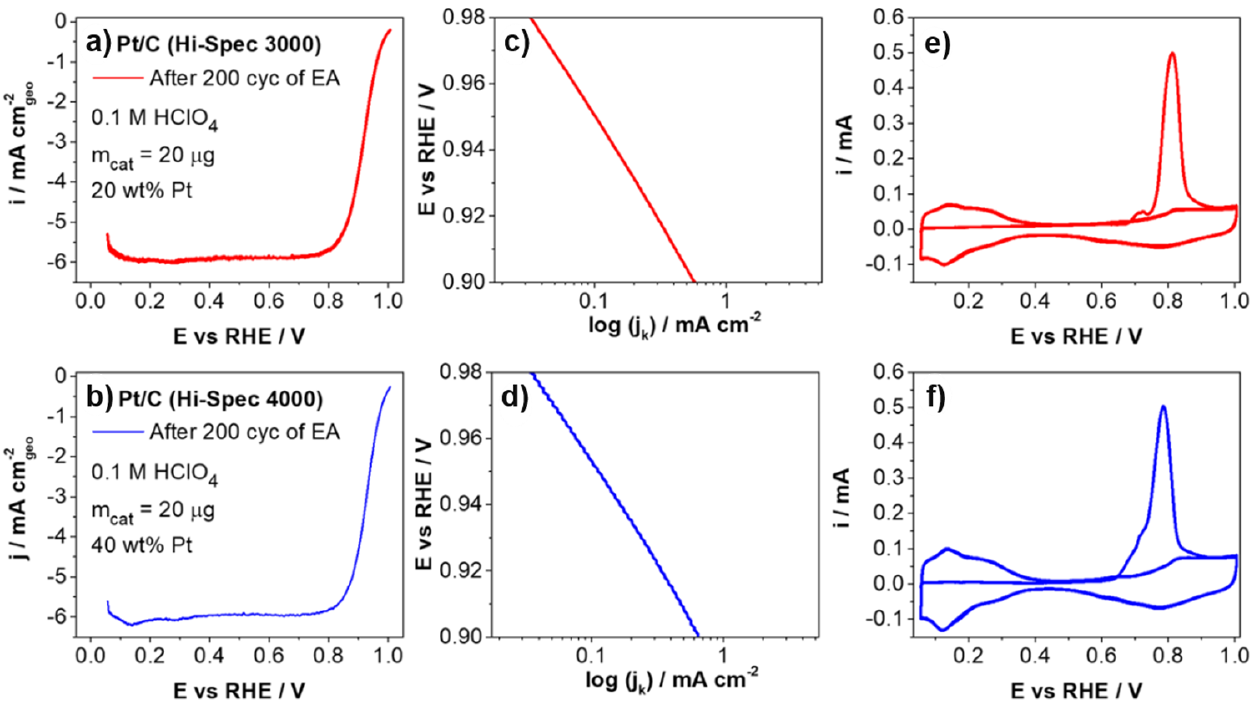
Figure 4. Comparison of activities and ECSAs of HiSpec 3000 and HiSpec 4000, determined on RDE-CV. ( a , b ) Oxygen-reduction reaction CV at 1600 rpm for HiSpec 3000 and 4000, ( c , d ) Tafel plots for HiSpec 3000 and 4000 and ( e , f ) CO electro oxidation CV for HiSpec3000 and 4000.